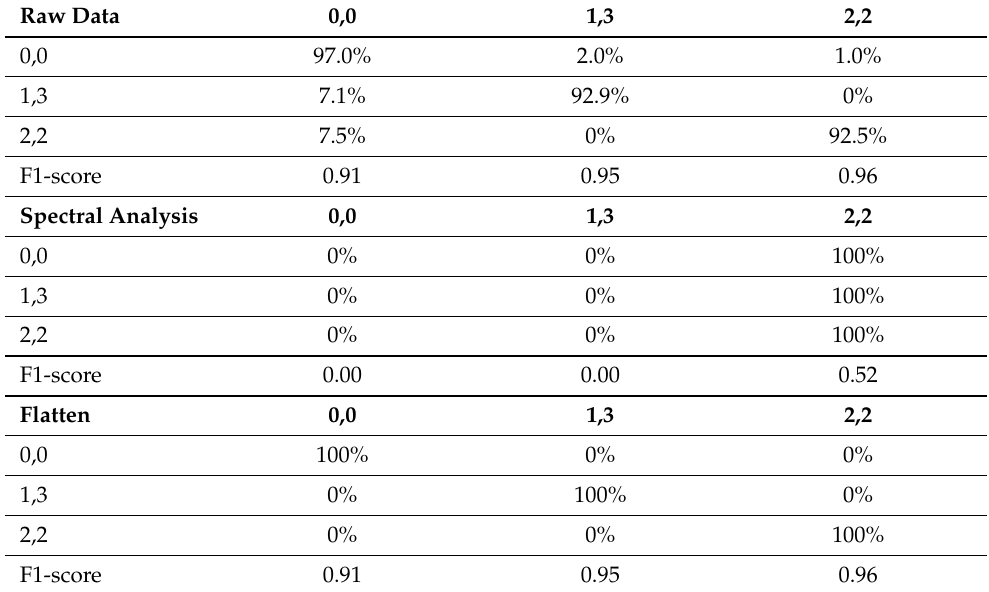
Table 8. Confusion matrix for the Raw Data, Spectral Analysis, and Flatten input processing